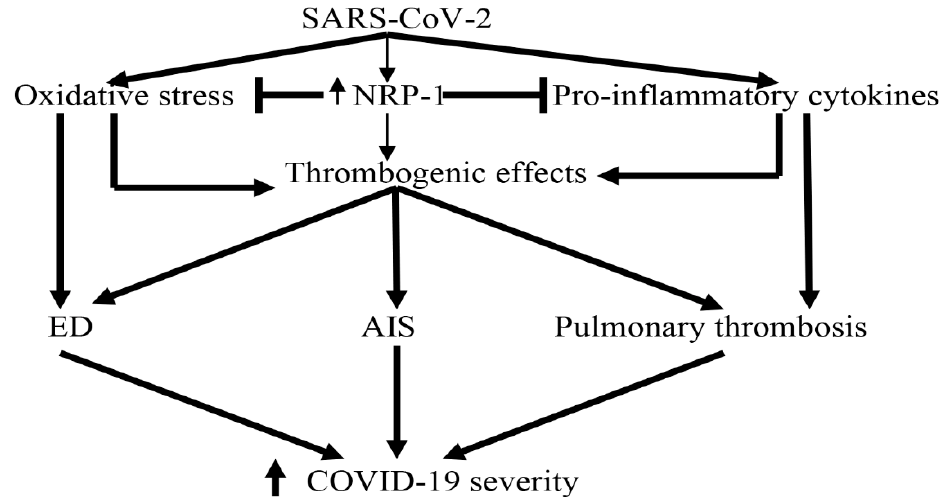
Figure 10. SARS-CoV-2 infection and thrombogenic effects: SARS-CoV-2 infection induces oxidative stress and the release of pro-inflammatory cytokines, and increases NRP-1 level that leads to thrombogenic effects, which lead to endothelial dysfunction (ED), acute ischemic stroke (AIS), and pulmonary thrombosis.